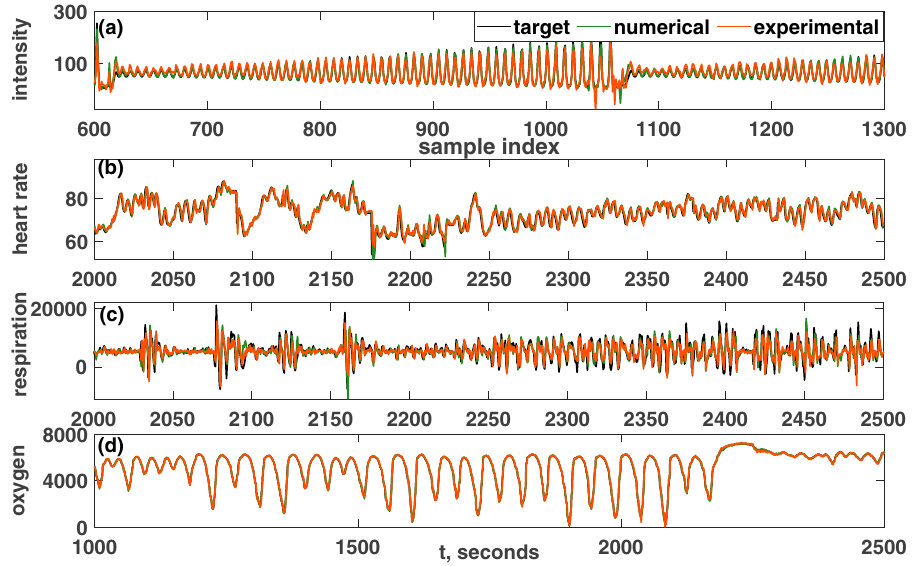
Figure 11. Comparison of the performance of the PRC for Santa Fe prediction tasks. ( a ) The Santa Fe chaotic time series of a laser intensity prediction task. Performance metric: NMSE exp = 0.0615 , NMSE sim = 0.02 . ( b ) The Santa Fe heart rate prediction task. NMSE exp = 6.0258 × 10 − Fe respiration force prediction task. NMSE exp = 0.1826 , NMSE sim = 0.1753 . ( d ) Santa Fe blood oxygen concentration prediction task. NMSE exp = 3.3287 × 10 − that: V µ = µ = 5 volts, A = 0.5 volts, � = 40 π rad/s, V ω 0 = ω 0 = 40 π volts, T p = 0.1 seconds, N = 1000 nodes, φ = π/ 3 rad, σ = 15 volts, β = 1.0 volts. Only a portion of the result is shown in each